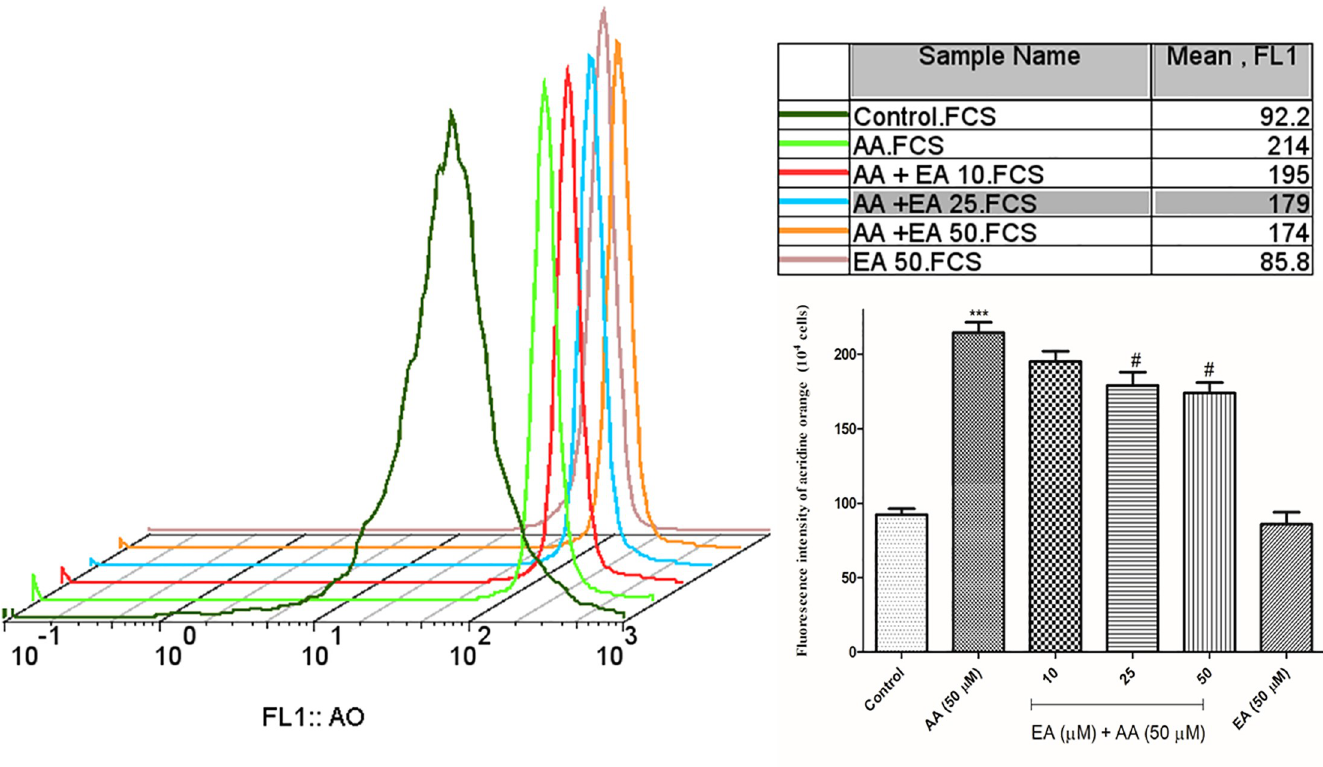
Fig 4. Ellagic acid decreases lysosomal integrity. Lysosomal integrity was analyzed by means of fluorescence intensity of acridine orange following AA exposure (4 hours) in the presence or absence of EA (10, 25 and 50 μ M) in human lymphocytes. Bar graphs with statistics. Data are presented as mean ± SD, n = 3, independent experiments repeated at least 3 times, ��� p < 0.001: Control versus AA; #p < 0.05: AA + EA versus AA-treated human lymphocytes ANOVA, Tukey’s test.